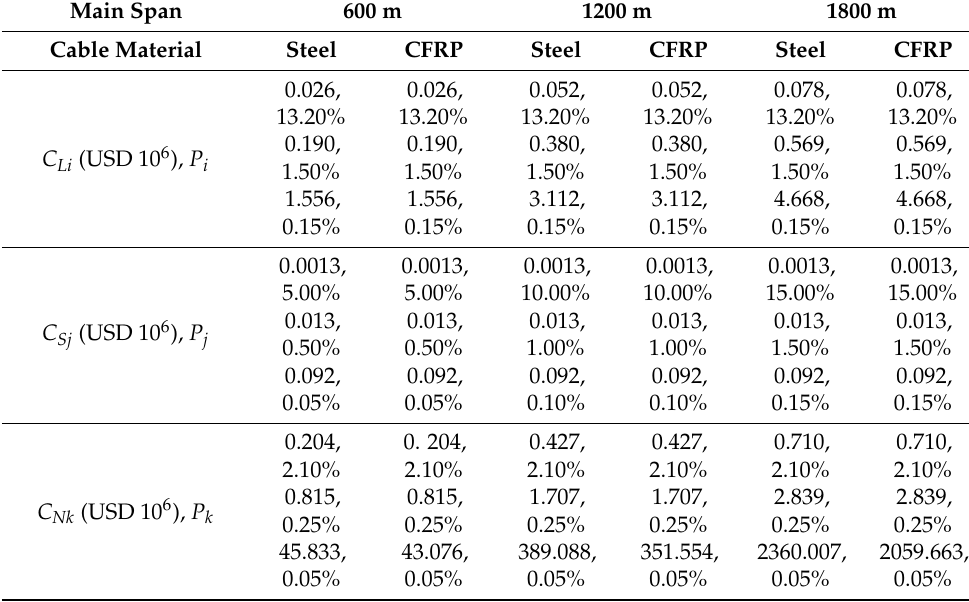
Table 10. Parameter values of vulnerability costs.